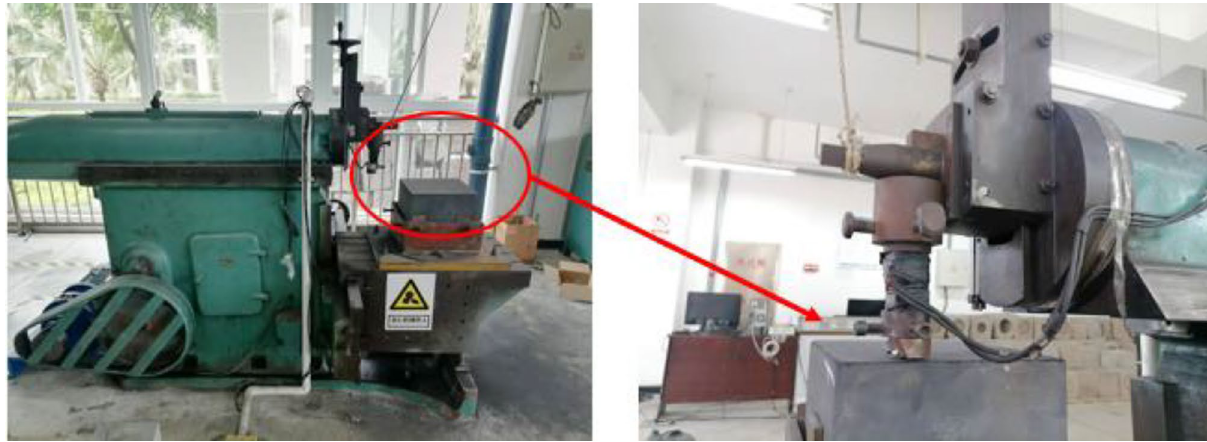
Fig. 10 Process of scraping and cutting shale using the test machine Table 3 Experimental